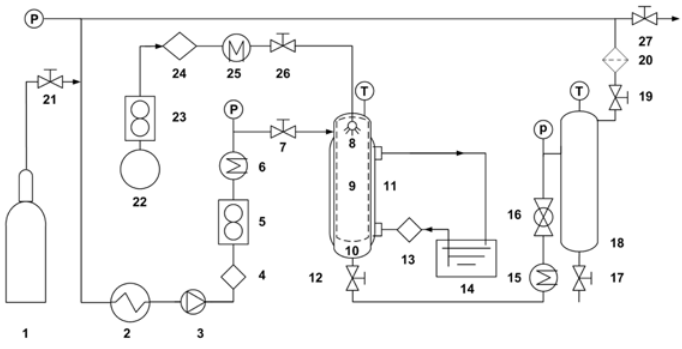
Figure 7. Schematic diagram of the experimental apparatus for the SAS process. 1, CO cooler; 3, CO pump; 4 and 24, liquid pump; 5 and 23, flowmeter; 6, 15 cylinder; 2, CO 2 2 and 25, heat exchangers; 7, 12, 17, 19, 21, 26 and 27, valves; 8, nozzle; 9, stainless steel core vessel of 150 μm; 10, precipitation chamber; 11, jacket bath; 13, hot water circulating pump; 14, thermal bath; 16, back pressure valve; 18, gas-liquid separation chamber; 20, filter; 22, liquid solution